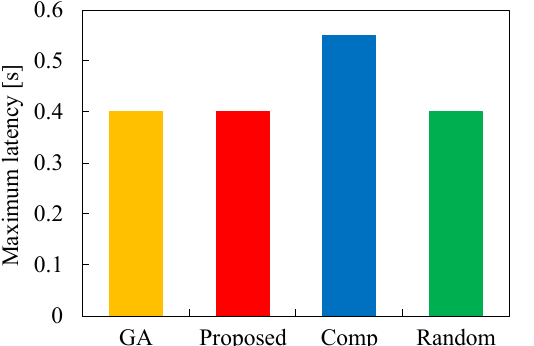
Figure 7. Maximum latency for each method in the case of N 1 = 50, τ = 0.2, and λ =